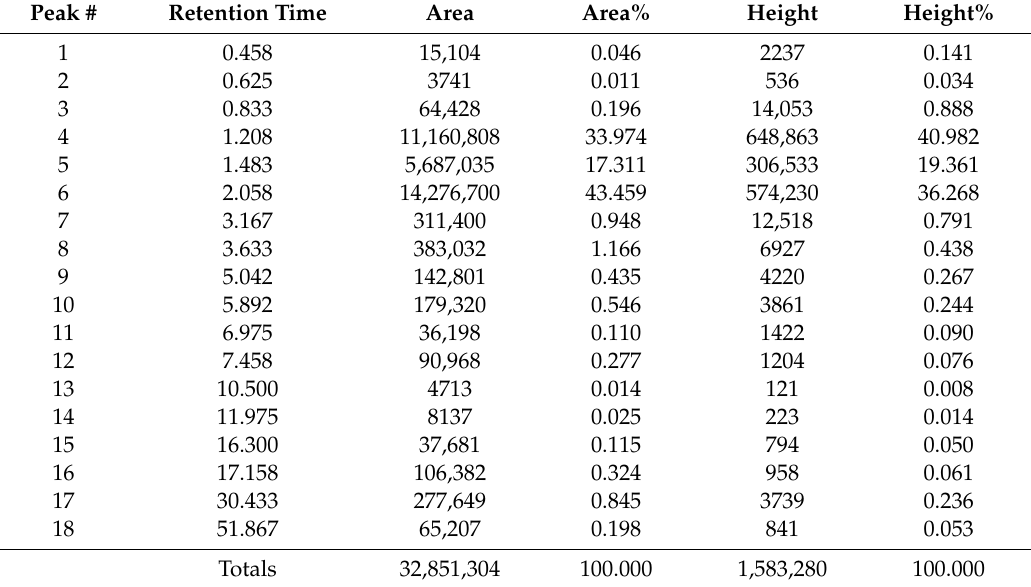
Table 2. Retention time, area, area %, height, and height % of the peaks separated by high-performance liquid chromatography / ultraviolet-visible (HPLC / UV-VIS) data of Ricinus communis leaf ethanol extract at the wavelength of 220 nm.